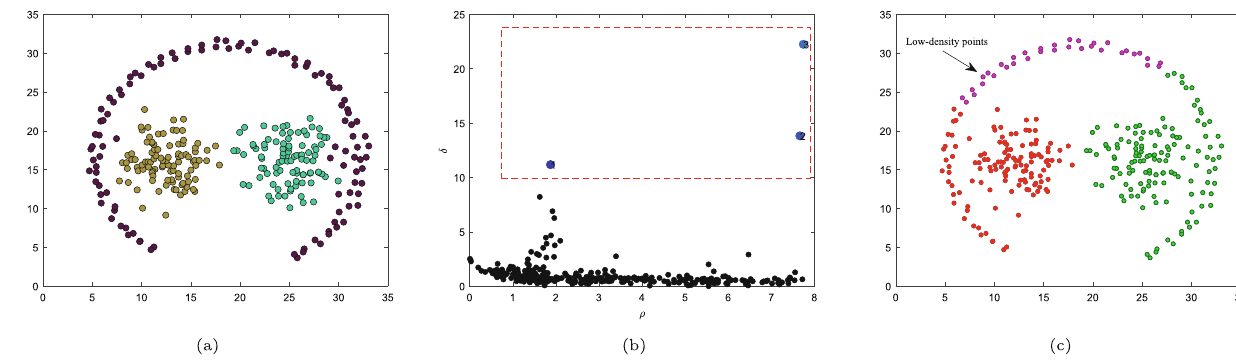
Fig. 1 Clustering results on Pathbased dataset for DPC algorithm. a True clustering result, b Decision graph, c Clustering result